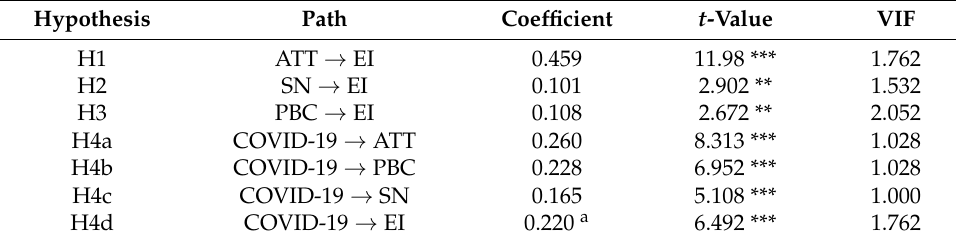
Table 5. Results of hypotheses testing via bootstrapping (direct